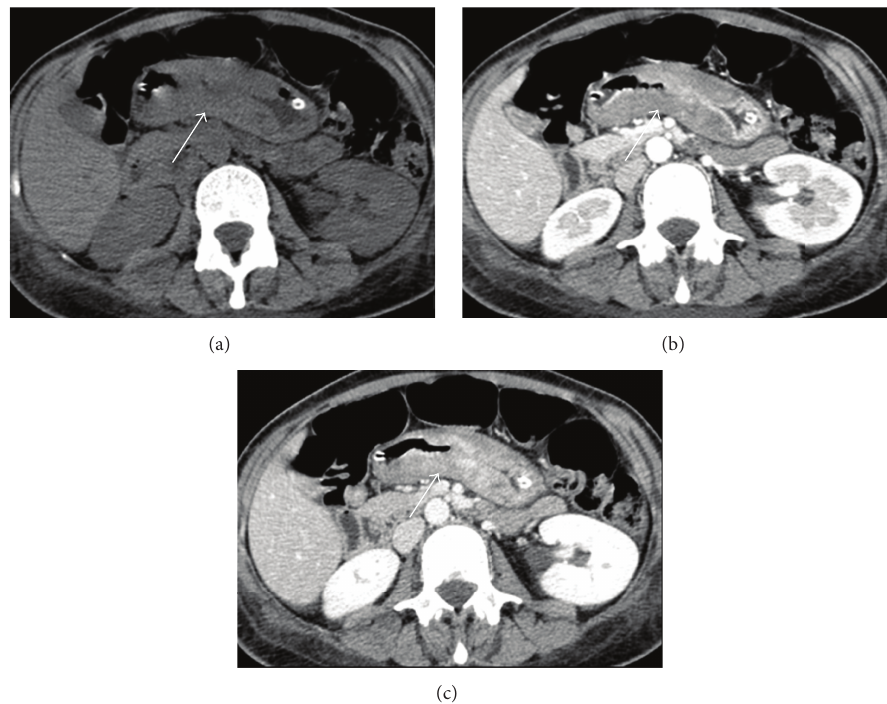
Figure 1: Abdominal CT scan in a 48-year-old female with gastric lymphoma. Axial pre- (a) and postcontrastographic CT scan in the arterial (b) and portal venous (c) phase show diffuse segmental (length: 9cm) wall thickening (thickness: 1,8cm) (arrows) of the gastric corpus and antrum with mild contrast enhancement. The patient underwent gastrectomy with ileal-jejunum